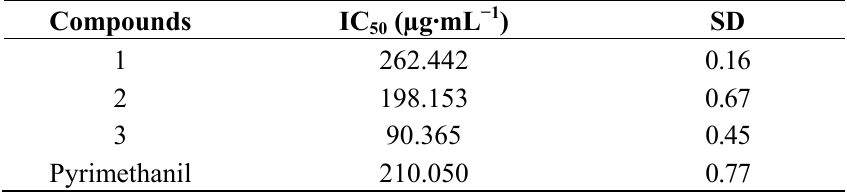
Table 2. Antifungal activities of compounds 1 – 3 against P. infestans